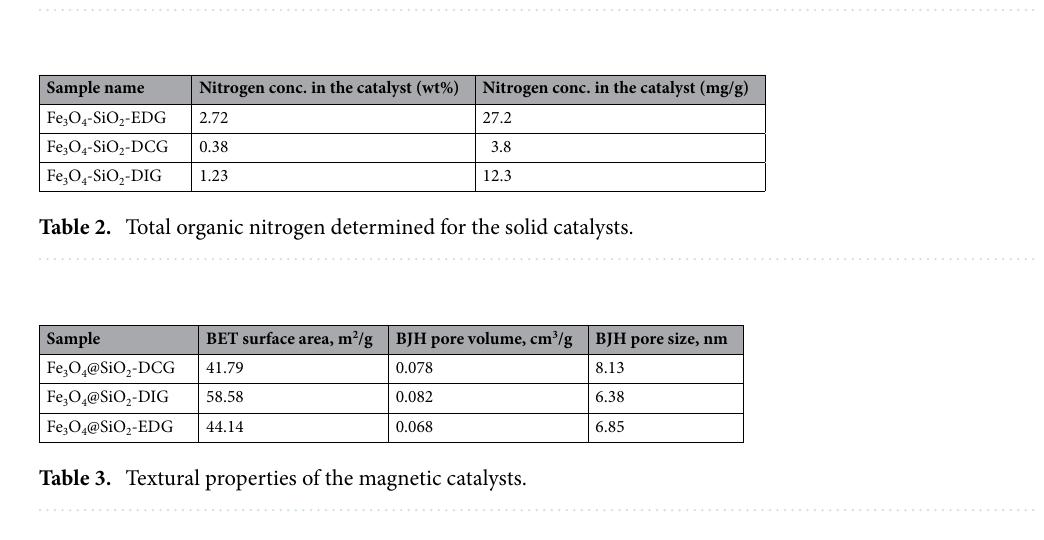
Figure 4. EDS spectra of Fe 3 O 4 @SiO 2 -DCG catalyst.